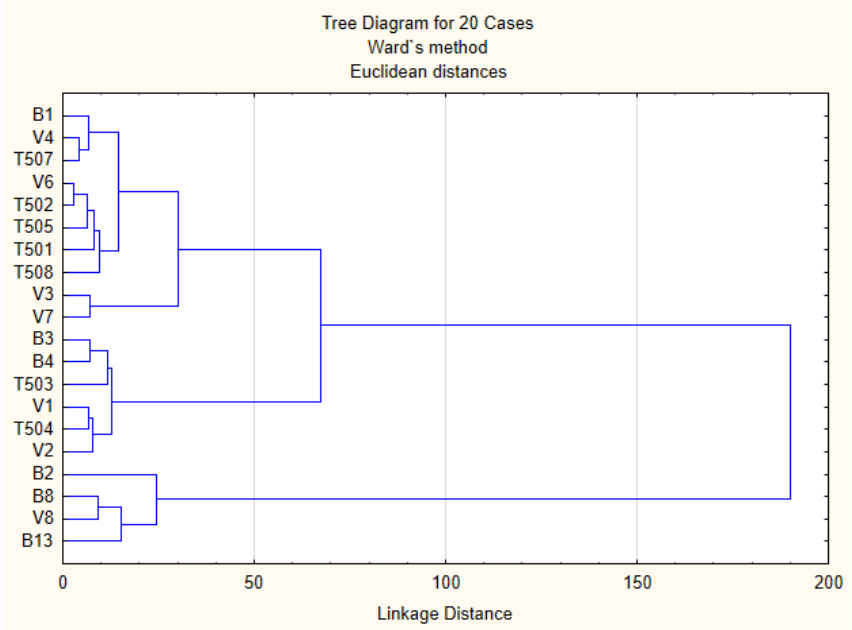
Figure 2. Projection of the cases on the plane spanned by the first and second principal components.